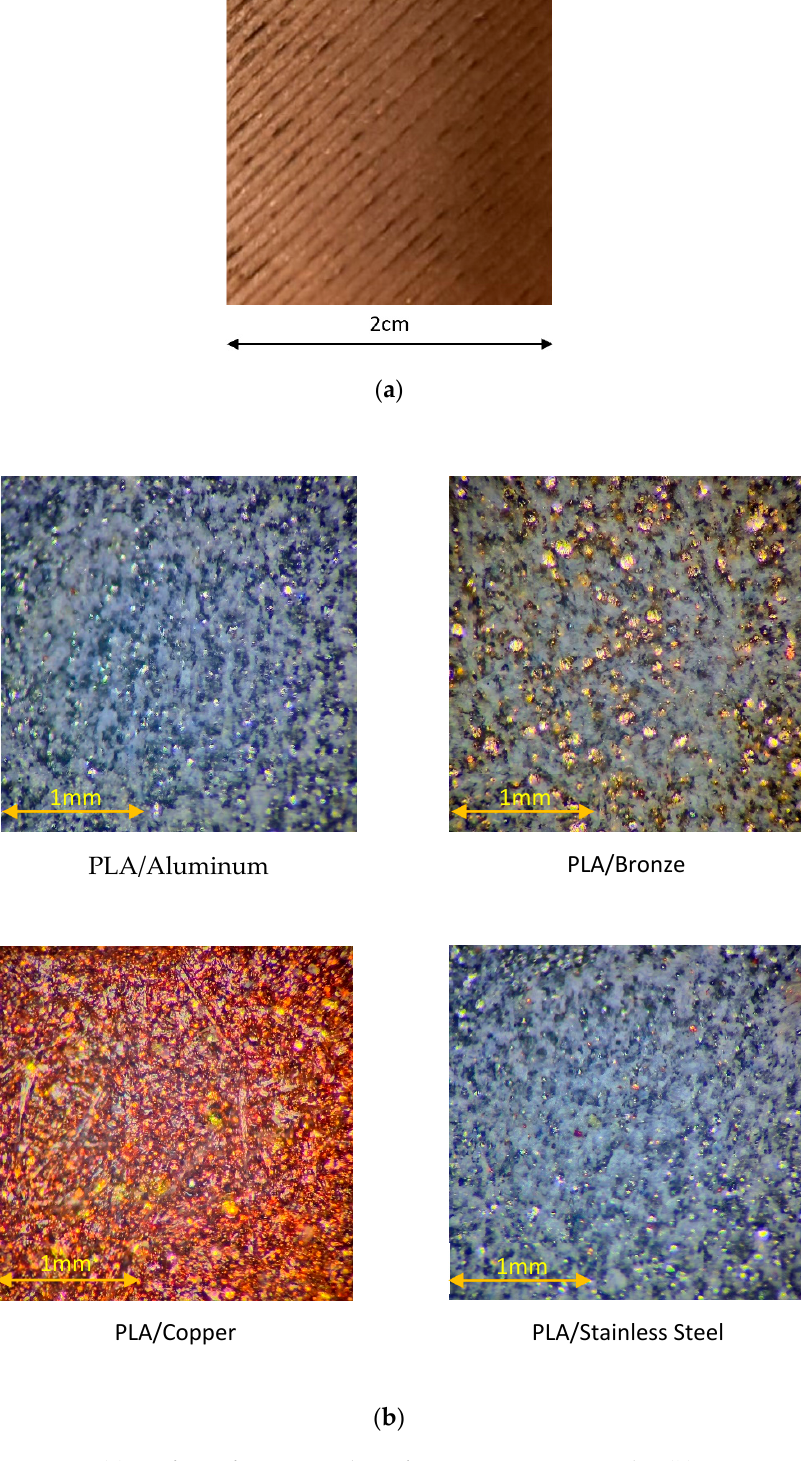
Figure 11. ( a ) Surface of 3D printed CU/PLA composite sample. ( b ) Microscopic images of 3D printed PLA composites with different metal particles.